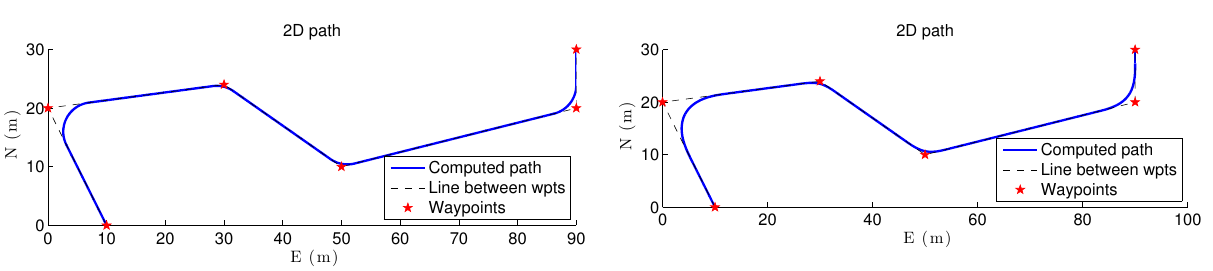
Figure 5: Clothoid smoothing path